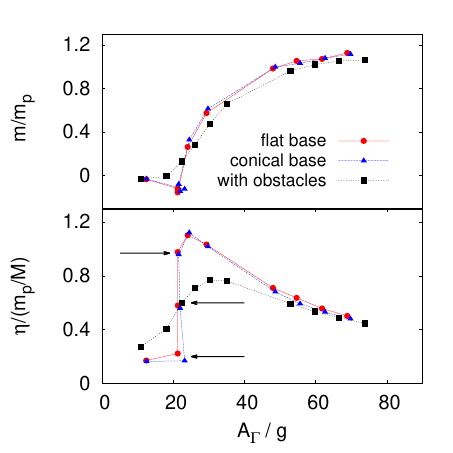
Figure 3. Apparent mass m / m p of the grains (top) and loss factor η (bottom) as a function of the amplitude of the acceleration A γ , for f = 15 Hz . Di ff erent A Γ are obtained by varying U . Results for di ff erent GDs (see